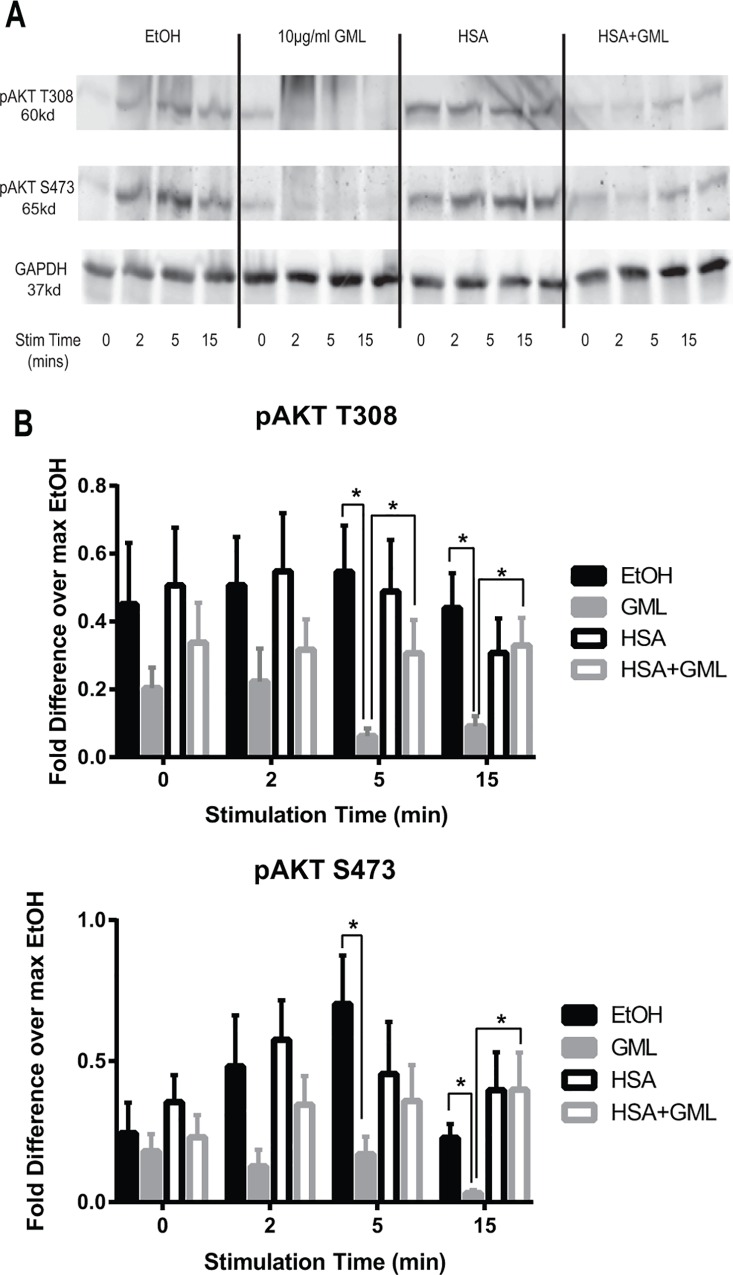
HSA restores AKT phosphorylation at both threonine 308 and serine 473 residues in GML treated cells.APBTs were treated with 0.1% ethanol vehicle control in serum free media (solid black lines), 10 μg/ml GML in serum free media (solid grey lines), 0.1% ethanol vehicle control in 1% HSA (dotted black lines), or 10 μg/ml GML in 1% HSA (dotted grey lines). Cells were stimulated by crosslinking 2 μg/ml of anti-CD3 for various times. Phosphorylation of AKT at threonine 308 and serine 473 were assessed by immunoblotting. Representative blots (A) and immunoblot quantification (B) are shown from 5 independent experiments with different individual donors. # denotes p<0.05 in Student t’s test comparing ethanol and GML treated cells in serum free media. * denotes p<0.05 in Student t’s test comparing GML treated cells in serum free RPMI with GML treated cells in 1% HSA.